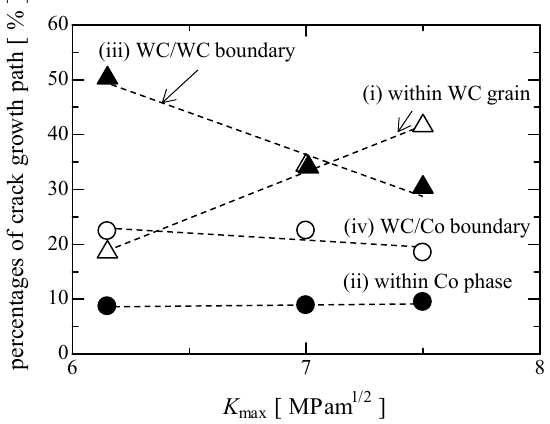
Figure 10. Relationship between percentage of each type of crack growth path and K max , observed at R = − 1.